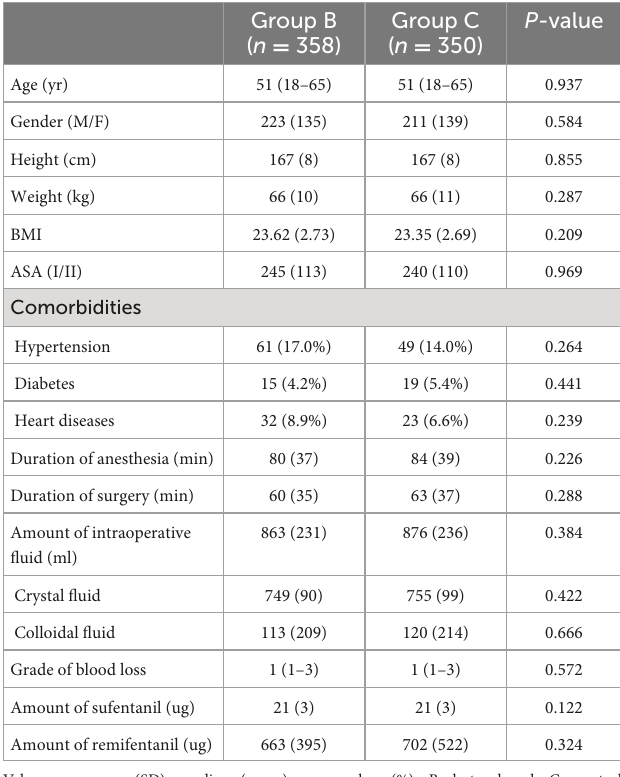
TABLE 1 Patient characteristics and operation details.